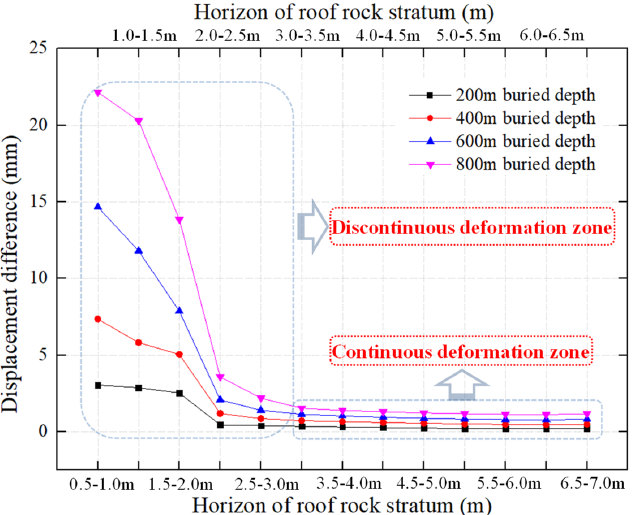
Figure 8. Displacement difference of rock masses at different horizons of the roadway roof.